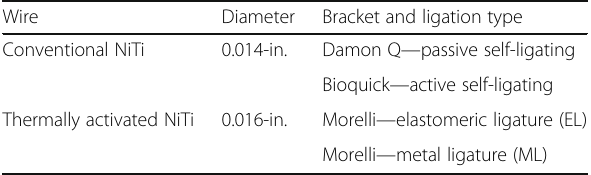
Table 1 Experimental groups